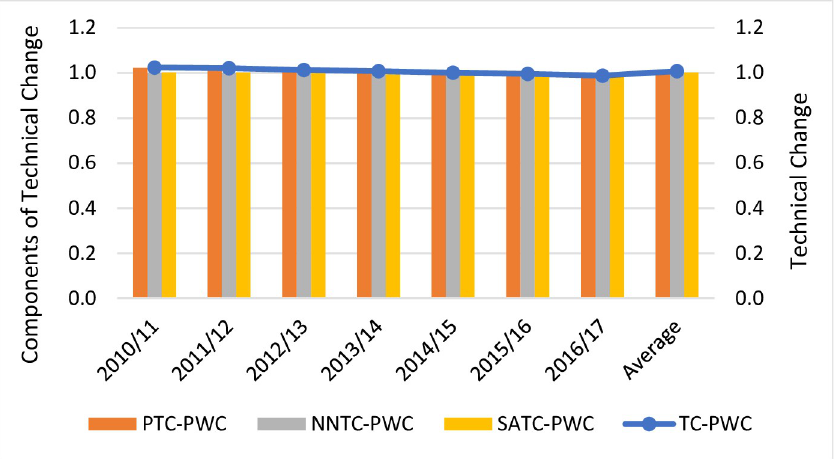
Fig 5. Technical Change (TC) estimations and its components (pure technical change -PTC-, non-neutral technical change -NNTC and scale-augmenting efficiency change -SATC-) for Chilean public water company (PWC).